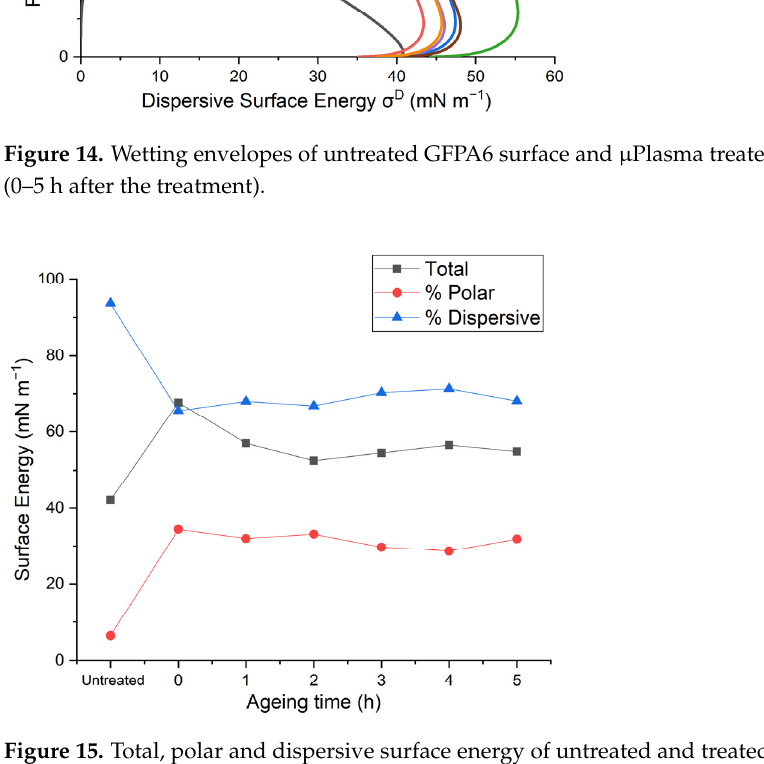
Figure 15. Total, polar and dispersive surface energy of untreated and treated GFPA6